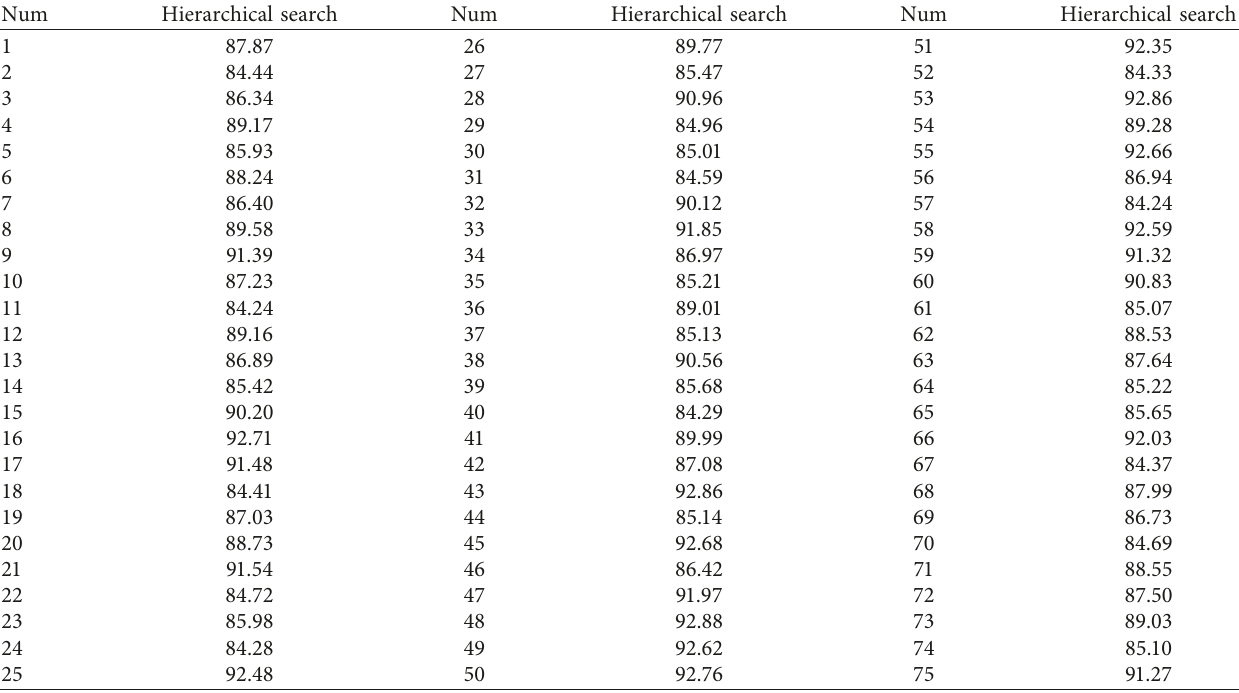
Table 2: The hierarchical retrieval effect of the hierarchical retrieval model of digital English teaching information based on ontology. Num